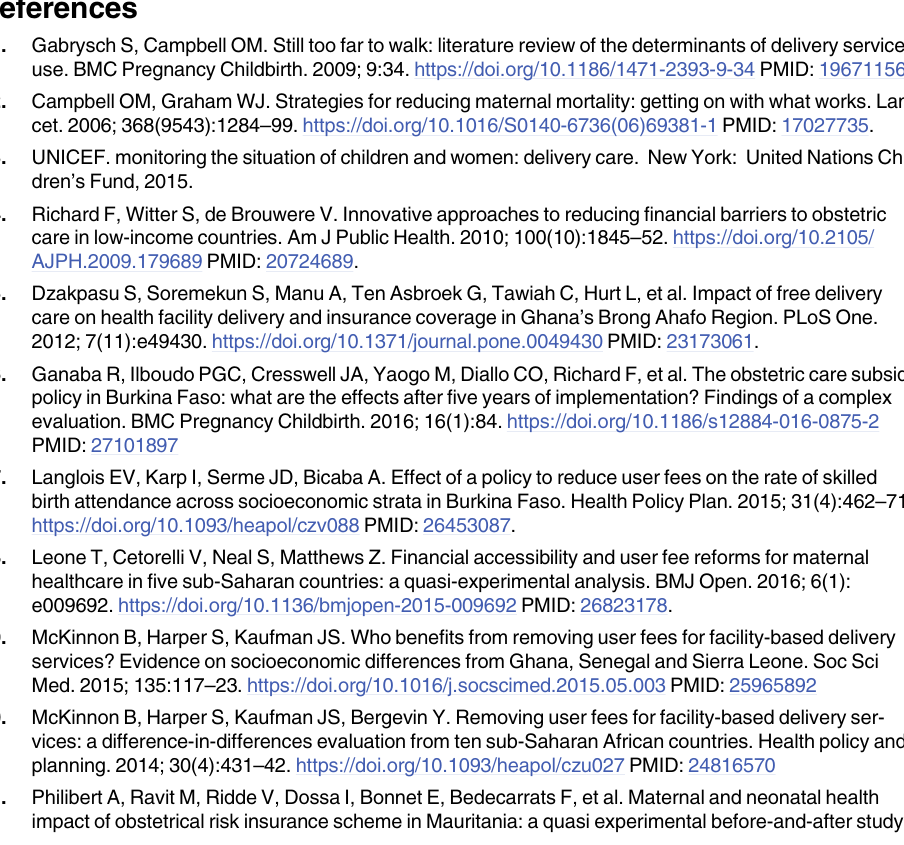
S2 Table. Estimates for the effects of the national subsidy on neonatal mortality in Burkina